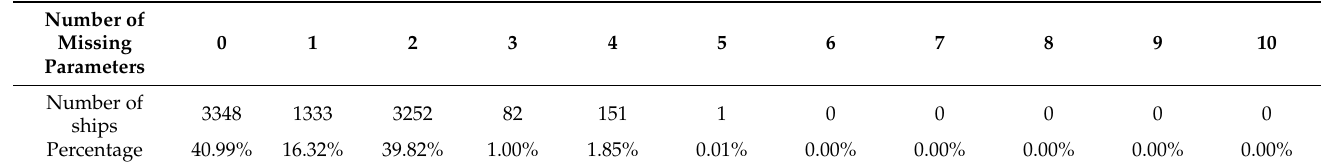
Table 3. Statistical analysis of the missing proportion of the main design parameters